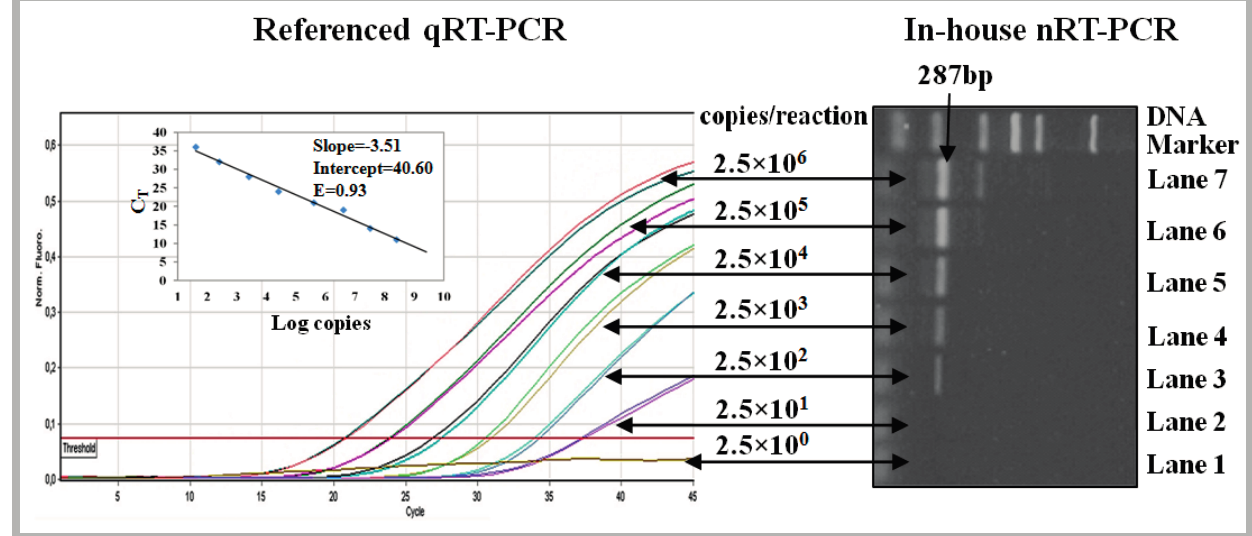
Figure A2. Comparison of the sensitivity of the in-house nRT-PCR and reference qRT-PCR methods for the detection of HEV RNA. The detection limit (2.5 × 10 2 copies/reaction) of the in-house nRT-PCR was less sensitive (10-fold) than that of reference qRT-PCR [21]. This results reflected that the real presence of HEV in shellfish might be higher than the results described in this study.